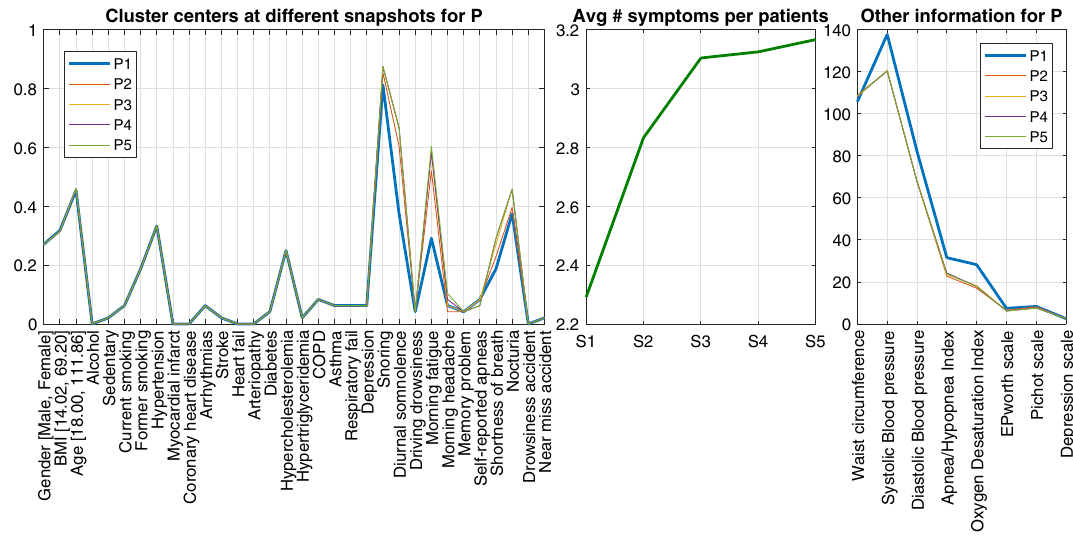
Fig. 21 The set P of 48 patients who start from the group C in S 1 with a low OSA severity but end up in the group F in S 5 with a medium OSA